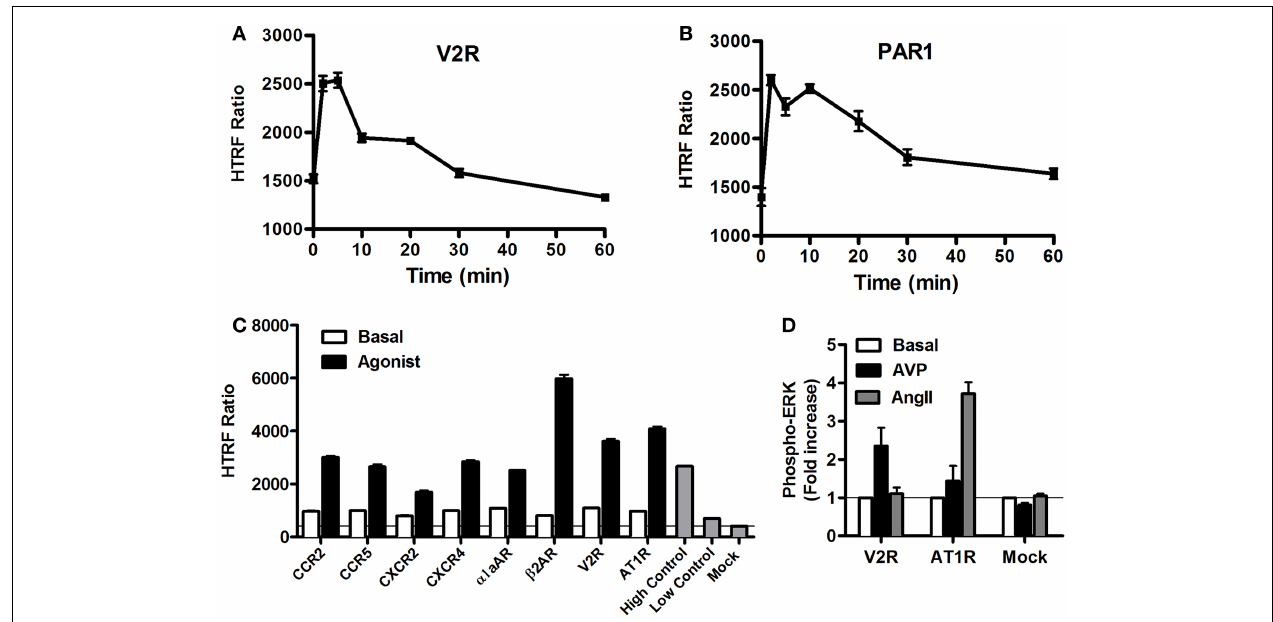
β 2AR, and AngII for AT1R. Phospho-ERK1/2 detection was performed using the two-plate protocol, which included the additional measurement of high and low controls instead of the cell lysate.The data are mean ± SEM of three independent experiments performed in duplicate (A–C) or represented as fold increase in Phospho-ERK1/2 over basal and the resultant values are mean ± SEM of three independent experiments performed in triplicate (D)